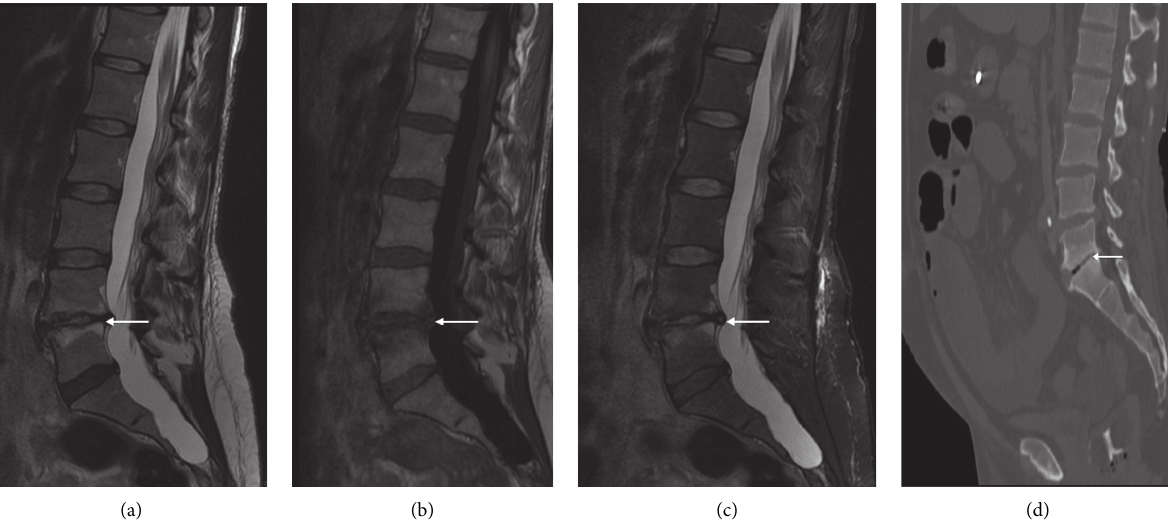
Figure 7: End plate degeneration. Sagittal T2 (a), T1 (b), and STIR (c) lumbar spine of a 40-year-old female presenting with right L5 radiculopathy in the background of low back pain. The fluid-hyperintensity (a, c) and T1 hypointense marrow signal (b) on either side of the L4/5 end plate (arrow), in the context of end plate irregularity and preservation of normal/hypointense disc signal, is consistent with inflammatory or Modic type I degeneration. The radiculopathy was secondary to impingement of the right L5 nerve root from the herniated disc at this level (not shown). Sagittal CT lumbar spine of a different patient (d) shows a vacuum cleft in the L5/S1 disc space with adjacent end plate sclerosis (Modic III degeneration). The vacuum cleft is a useful sign of